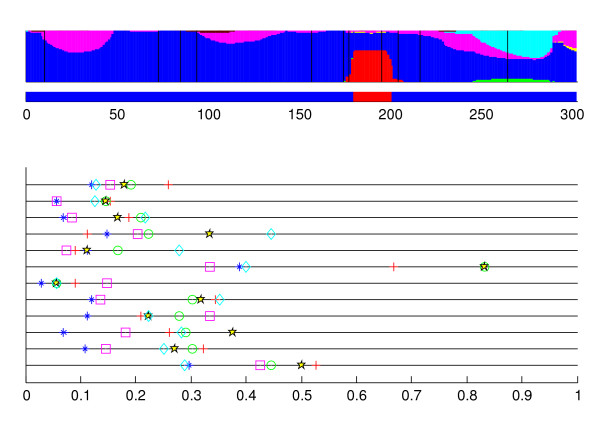
Coalescent strain #3. The results for the strain #3 in the coalescent simulation.